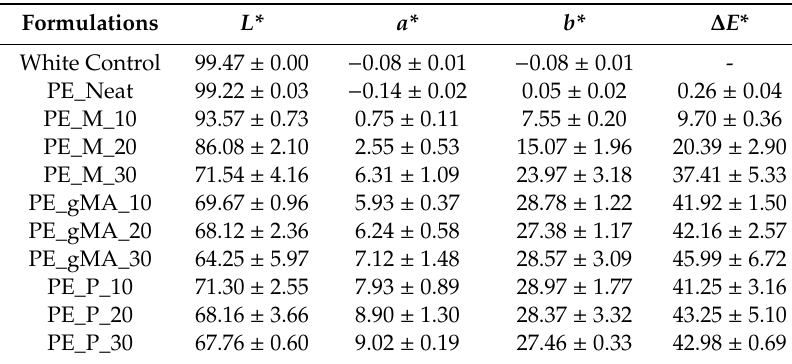
Table 2. Colour coordinates of BioPE_CSS